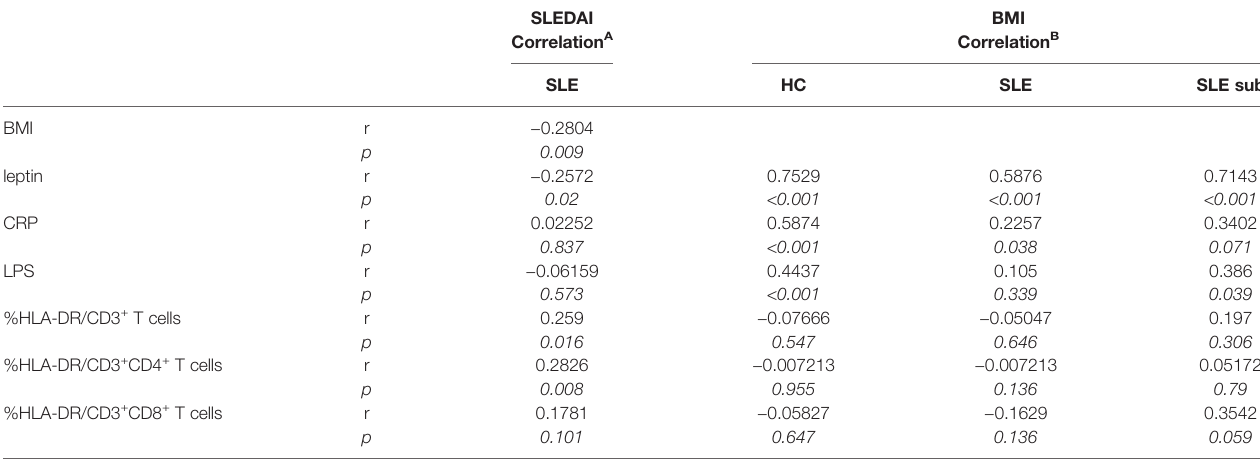
A SLEDAI correlation: Association between disease activity (SLEDAI) and obesity (BMI, serum leptin), systemic in fl ammation (CRP), gut leakage (serum LPS) as well as adaptive immune activation (% HLA-DR expression on CD3 + , CD3 + CD4 + and CD3 + CD8 + T cells) in all enrolled SLE patients (n = 86). B BMI correlation: Association between obesity (BMI) and leptin, systemic in fl ammation (CRP), gut leakage (serum LPS) as well as adaptive immune activation (% HLA-DR expression on CD3 + ,CD3 + CD4 + andCD3 + CD8 + Tcells)inhealthycontrols(HC;n=67),allenrolledSLEpatients(SLE;n=86)andade fi nedgroupofSLEpatientswithSLEDAI ≤ 2,receivingatreatment of no more than hydroxychloroquine/chloroquine, prednisone ≤ 5 mg and no DMARDs/biologicals (SLE sub; n = 29). A,B Graphed are numerical values, Spearman ’ s rank correlation coef fi cient and its